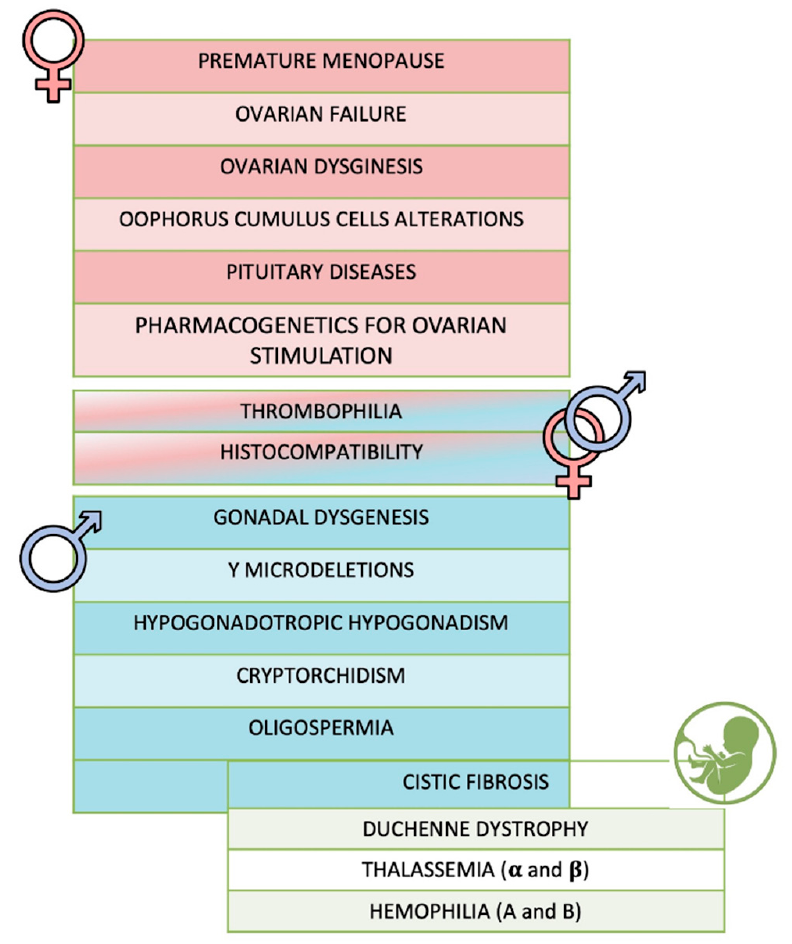
Figure 2. One4Two ® custom panel design. The final panel included 54 genes related to specific causes of both female and male infertility, and the causative genes of common inherited diseases. For each gene, all the coding regions, 100 bp at 3’ and 5’ of each exon, the annotated promoters and 3’ UTRs were included in the design, obtaining a total target of 1